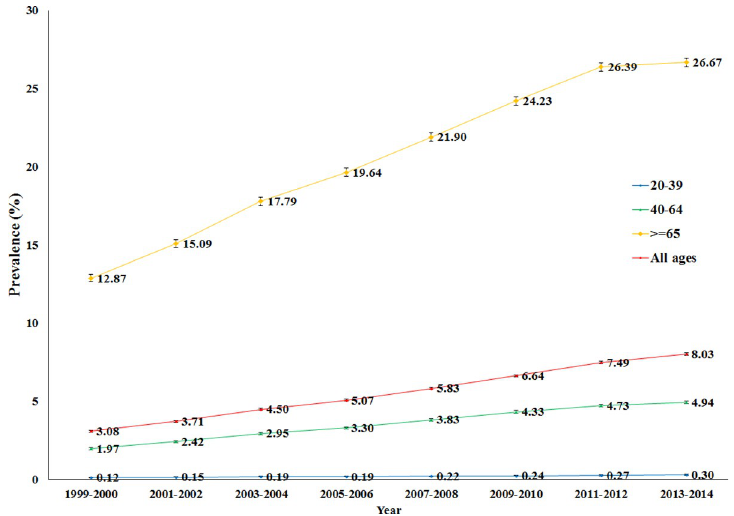
Fig 2. Trends in polypharmacy among adults in the Netherlands 1999–2014, stratified by age.